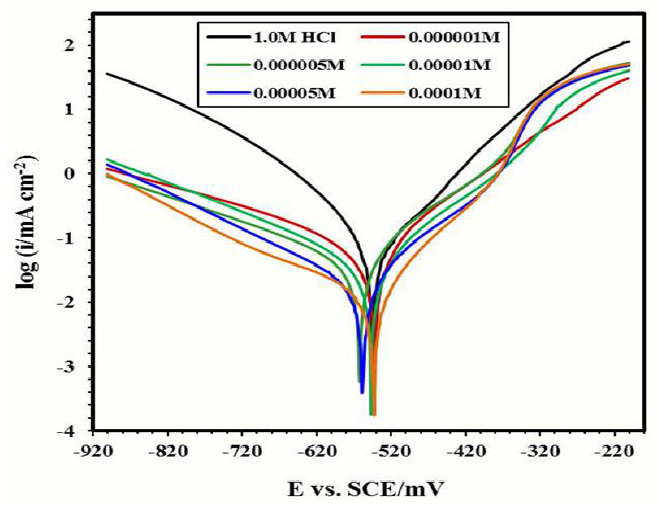
Figure 4. Polarization curves of carbon steel corrosion in 1 N HCl solution containing different concentrations of II b inhibitor at 25 °C . Table 5. Electrochemical polarization parameters of carbon steel corrosion in the presence different concentrations of II b and IIc